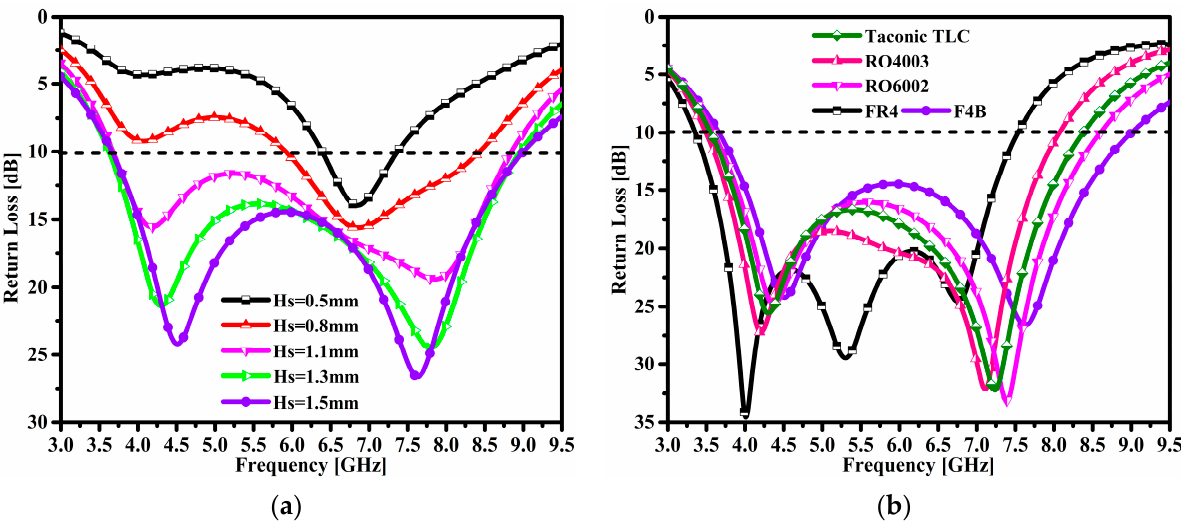
Figure 4 . Parametric study of defined variables: ( a ) impact of substrate height and ( b ) impact of different substrate materials.